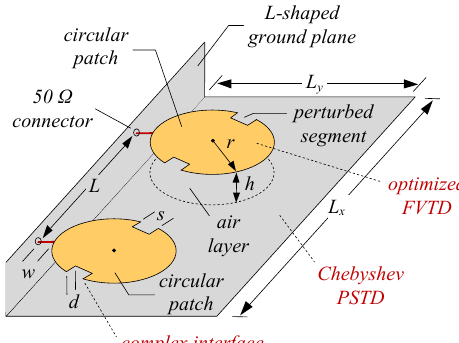
Figure 7: A two-port coaxial waveguide with a dielectric slab and several pairs of MEMS actuators. Modeling regions: complex-interface schemes for the actuators, optimized FVTD technique for the slab, and PSTD algorithm for the interior of the waveguide.